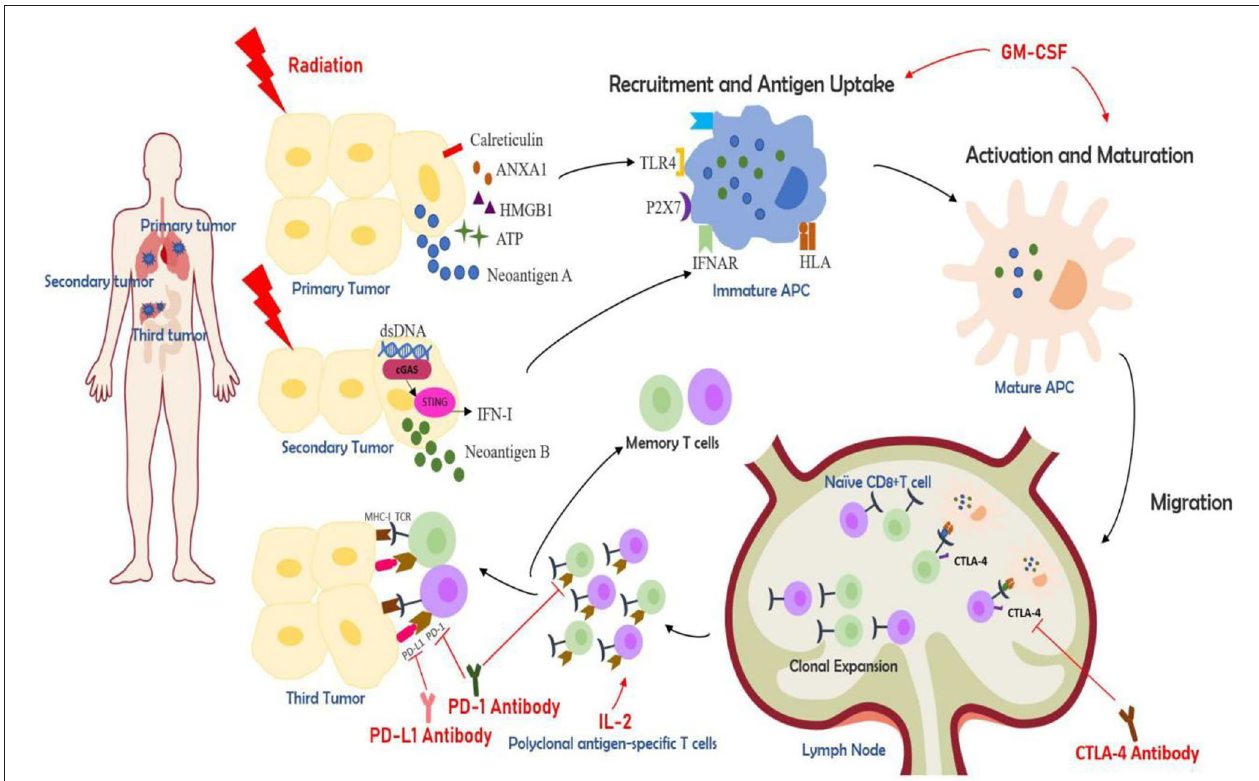
FIGURE 1 | The partial mechanisms of multisite radiotherapy combined with immune checkpoint inhibitors (ICIs) and biological response modifiers (GM-CSF or IL-2). Radiotherapy induces immunogenic cell death (ICD), which exposes and releases danger-associated molecular patterns (DAMPs) like calreticulin, HMGB1, ATP, ANAX1, and similar ( 12). cGAS-STING pathway is activated by the cytolytic double-strand DNA and results in the release of IFN-I (10). Radiation can also generate tumor neoantigens. Multisite radiotherapy can overcome the insufficient tumor-associated antigen (TAA) exposure caused by tumor heterogeneity ( 7). ICDs can recruit antigen-presenting cells (APC) like dendritic cells (DC). APCs can take up antigens and further be activated, which can be augmented by GM-CSF. DCs then migrate to lymph nodes, presenting antigens to T cells and prime a cytotoxic T lymphocyte (CTL)-mediated immune activation ( 26, 27). The activated CTLs initiate clonal proliferation and then travel to the irradiated lesions or distant tumor sites, exerting killing effects. The cytokine IL-2 is essential for the proliferation, differentiation, and survival of T cells (28). CTLA-4 antibody, PD-1 antibody, and PD-L1 antibody, known as ICIs, can increase CTL activation and boost the synergistic anti-tumor